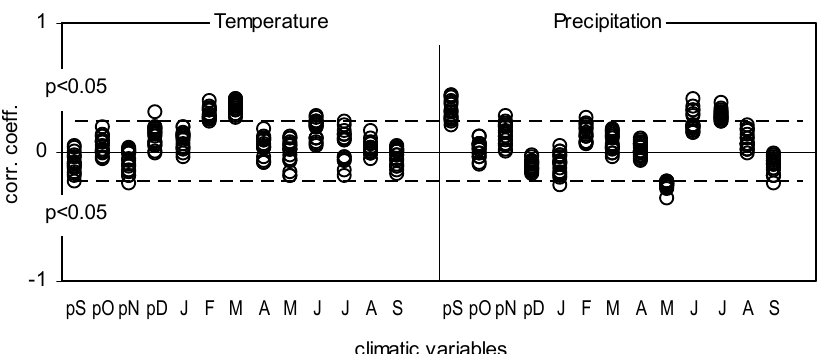
Figure 10. Correlation coefficients between 18 site indexed chronologies (BAII) and mean monthly temperature and precipitation, from September of the previous year (pS) to September of the current year (S).